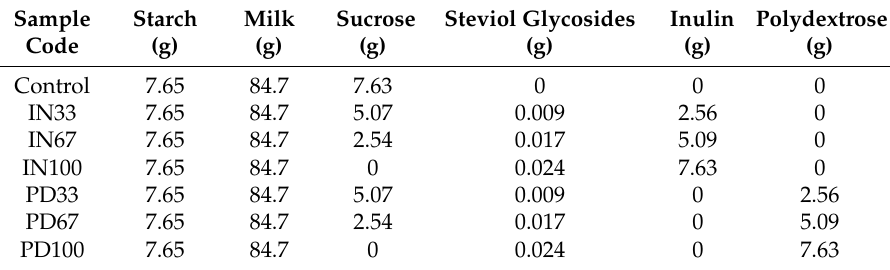
Table 1. Sample codes and recipe compositions per 100 g of ready